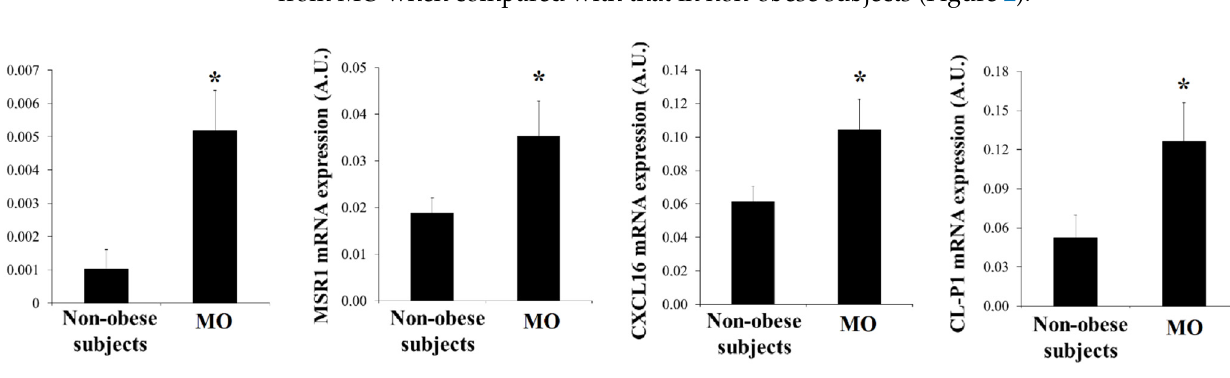
Figure 2. Levels of mRNA expression of scavenger receptors in human visceral adipocytes from non-obese subjects and patients with morbid obesity (MO). Data are the mean ± SEM. * p < 0.05: significant differences between non-obese subjects and MO.